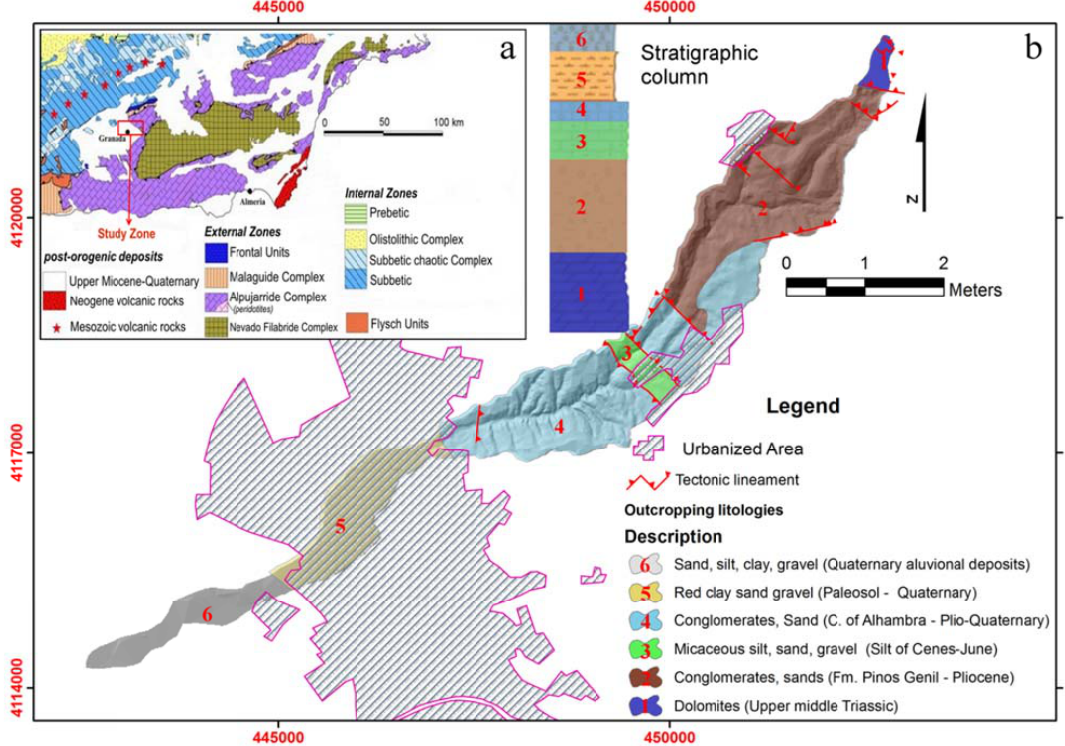
Fig. 2. Geological setting of the study zone. Regional geology (a) (modified from Vera, 2004); Beiro river basin (b) . Coordinate Reference System: UTM zone 30 European Datum Fig. 2 - Geo ological settinng of the study